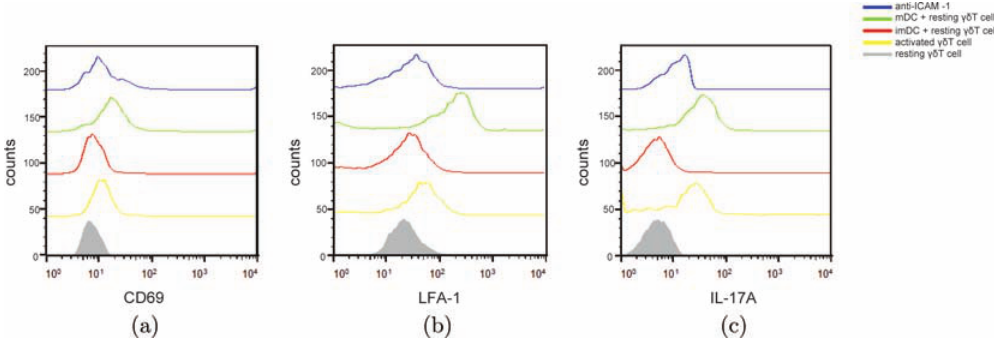
Fig. 3. (a) Activation of (cid:1)(cid:2) T cells co-cultured with DCs. (b) The (cid:1)(cid:2) T cells co-cultured with mature DCs expressed higher levels of activation markers (CD69, LFA-1; green line) than did (cid:1)(cid:2) T cells not cultured with DCs (shadow line), or that on the (cid:1)(cid:2) T cells co- cultured with immature DCs (red line), or that on the (cid:1)(cid:2) T cells co-cultured with anti-ICAM-1 antibody pretreated DCs (blue line). (c) IL-17A expression is greater in (cid:1)(cid:2) T cells co-cultured with mature DCs (green line) than in (cid:1)(cid:2) T cells cultured without DCs (shadow line), or that on the (cid:1)(cid:2) T cells co-cultured with immature DCs (red line), or that on the (cid:1)(cid:2) T cells co-cultured with anti- ICAM-1 antibody pretreated DCs (blue